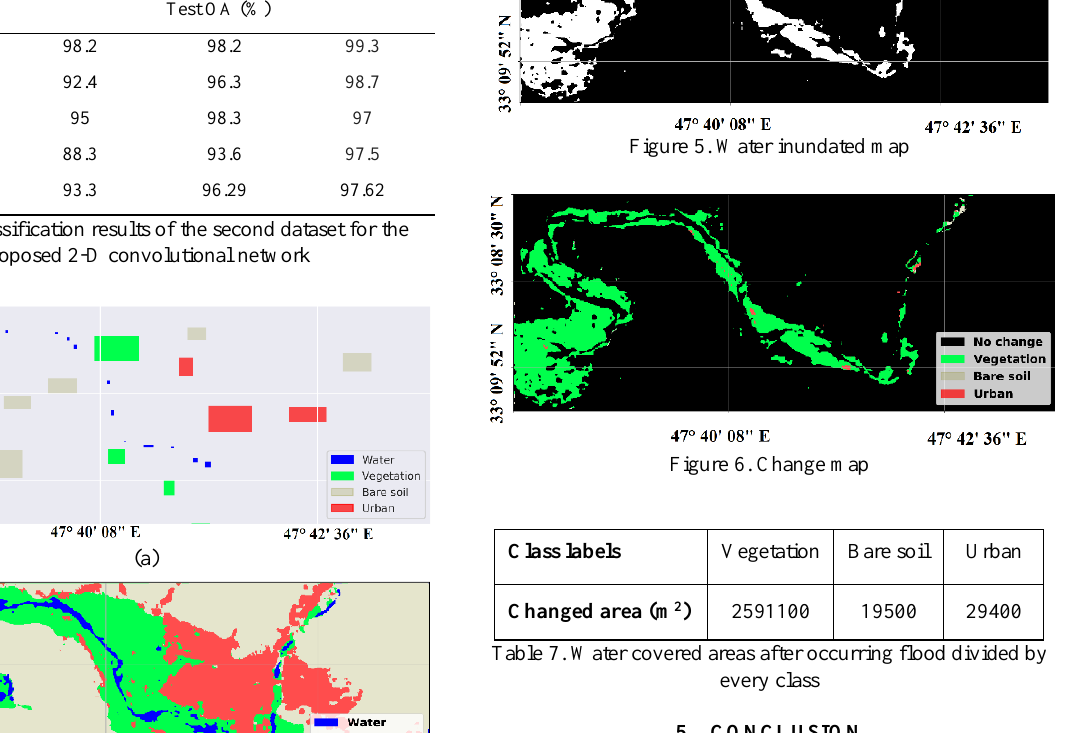
Figure 6. Change map